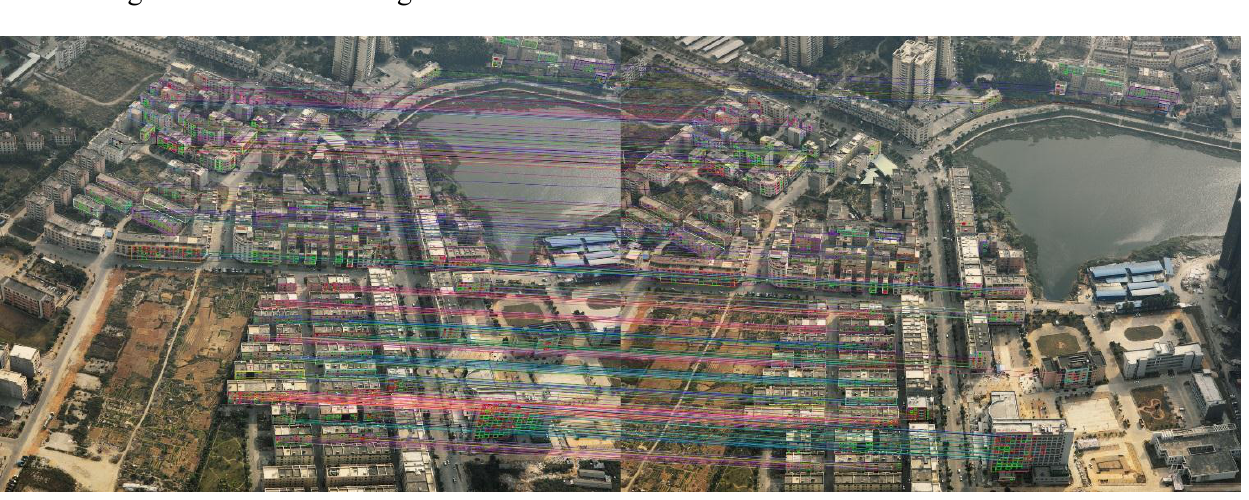
Figure 18. Corresponding windows linked by lines. Table 4. Confusion matrix and common performance metrics calculated from window